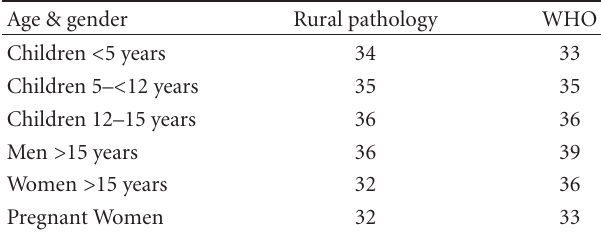
Table 1: Hematocrit thresholds for definition of anemia.